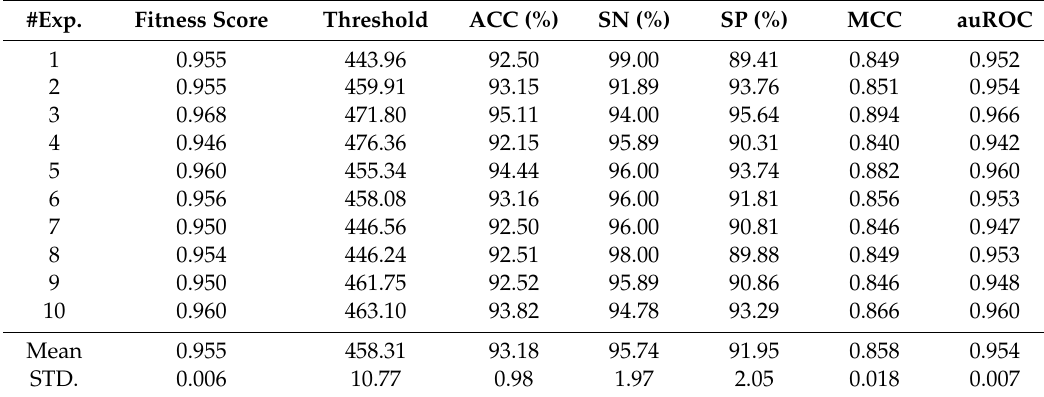
Table 2. Comparison of ten SCM models with ten di ff erent optimized dipeptide propensity scores (opti-DPS) over 10-fold